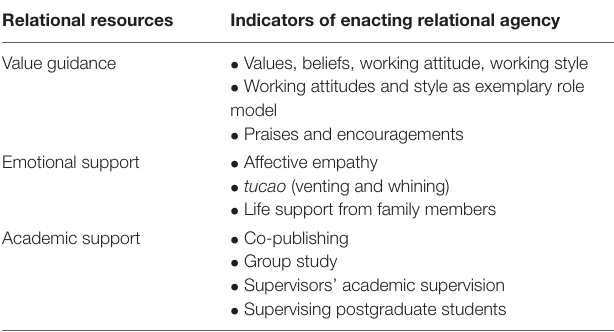
TABLE 2 | Relational resources that emerged in the